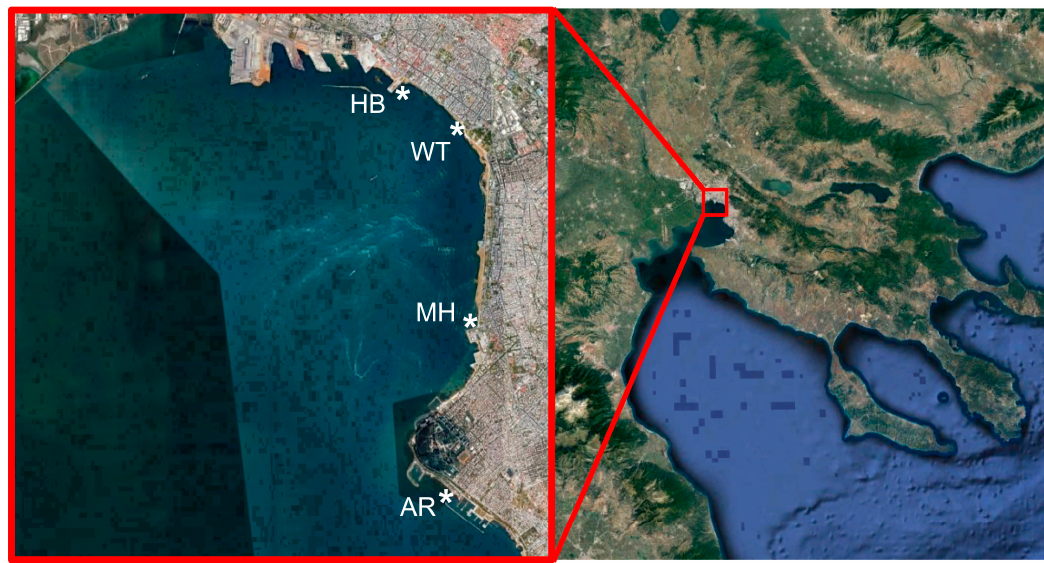
Figure 1. Study area in Thermaikos Bay, indicating the location of the four sampling sites (*). WT: White Tower, AR: Aretsou, MH: Music Hall, HB: Harbor.